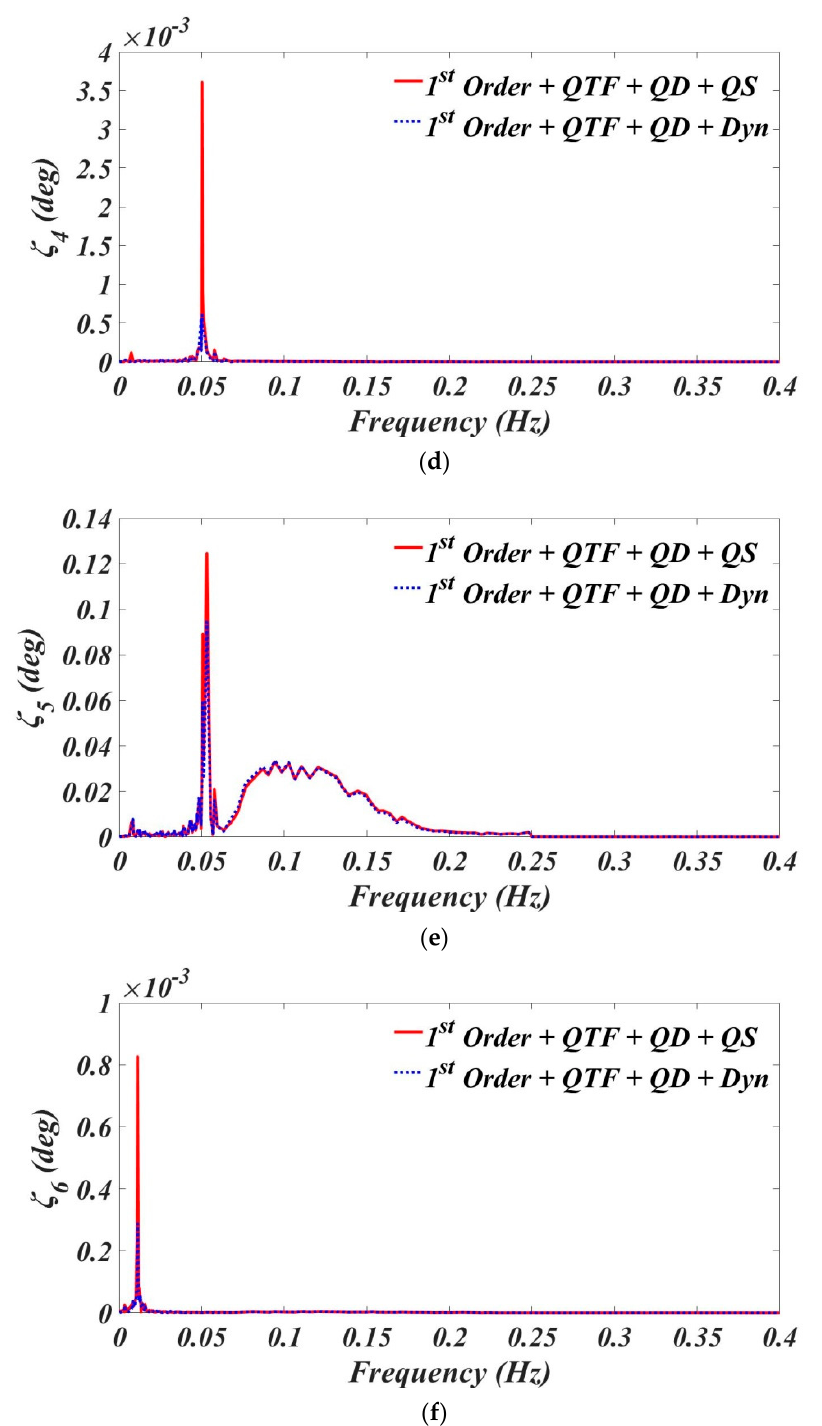
Figure 13. The effects of the mooring models on the motion responses in ( a ) the surge, ( b ) the sway, ( c ) the heave, ( d ) the roll, ( e ) the pitch, and ( f ) the yaw modes, respectively.